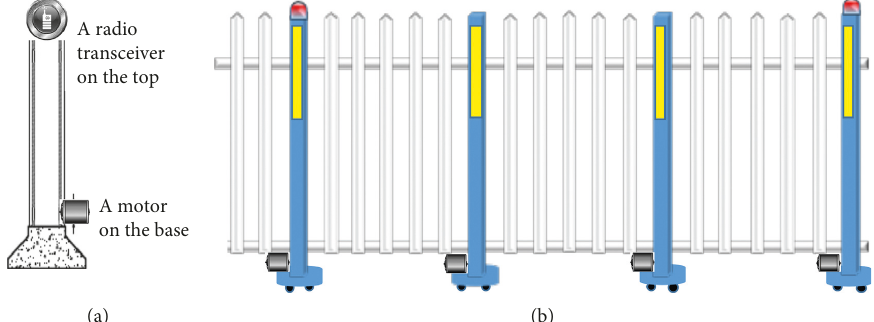
Figure 1: (a) The mechanical structure of an active spacer bar. (b) A smart reversible lane where the spacer bars are connected with longitudinal